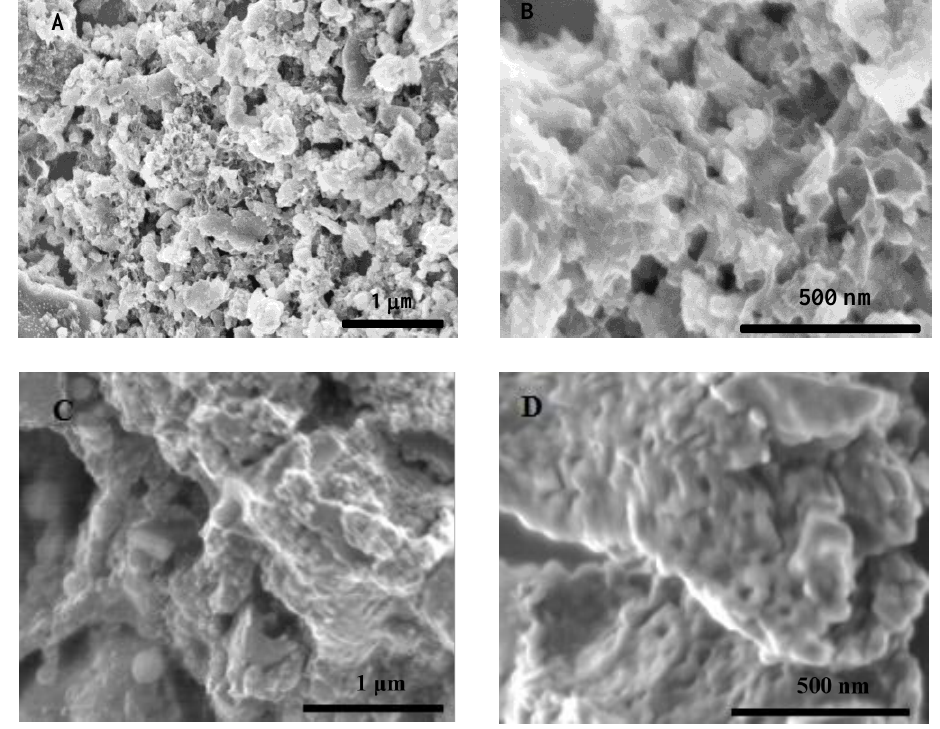
Figure 1. Scanning electron microscopy images of Fe 2 O 3 /N-PCs-850 ( A , B ) and bare N-doped porous carbon support alone without Fe 2 O 3 ( C , D ).